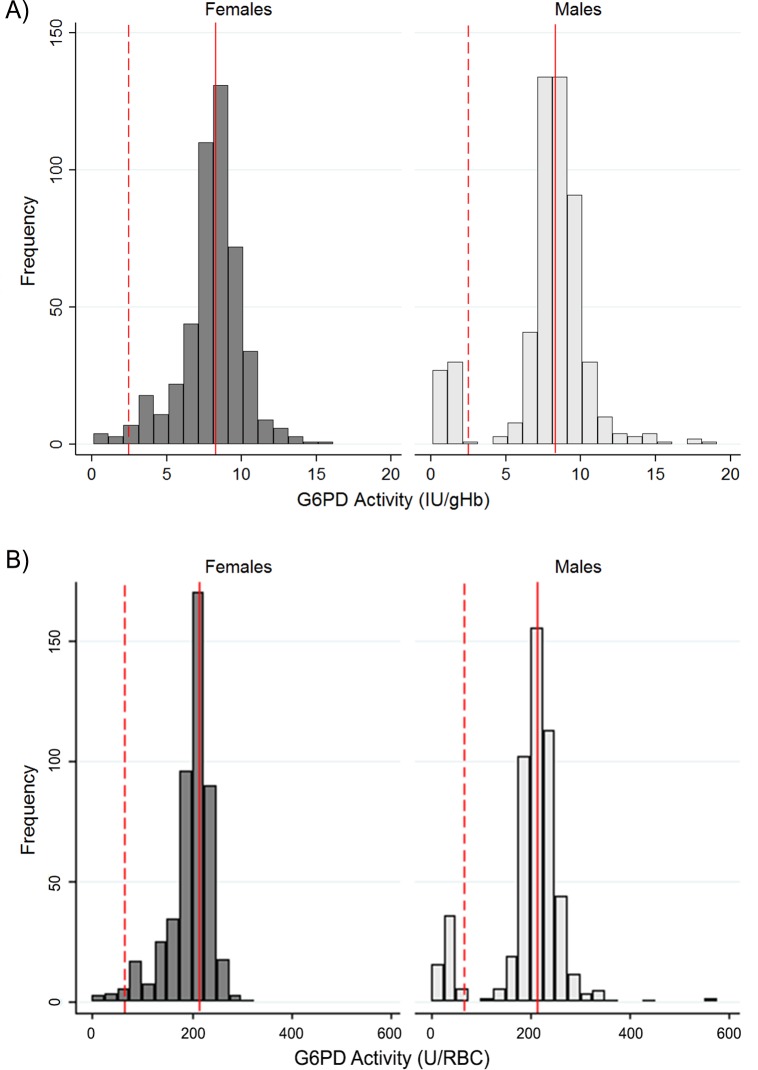
Distribution of G6PD activity in male and female population.A: Histograms for ranges of G6PD activity for both males and females based on G6PD activity normalized for hemoglobin concentration. B: Histograms for ranges of G6PD activity for both males and females based on G6PD activity normalized for red blood cell count. The red vertical reference lines are the adjusted population median, the red dashed reference lines are the 30% activity threshold.